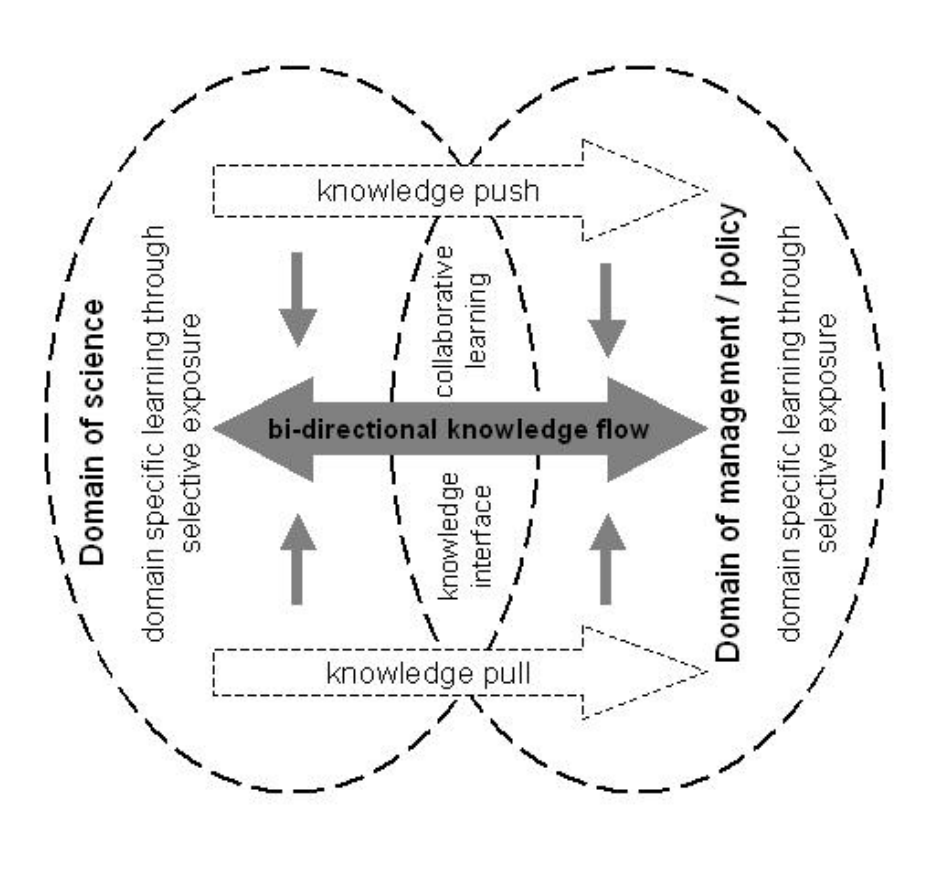
Fig. 3. The knowledge interface facilitates collaborative learning, shared understanding of key concepts, and co-evolution toward common purpose, intent, and